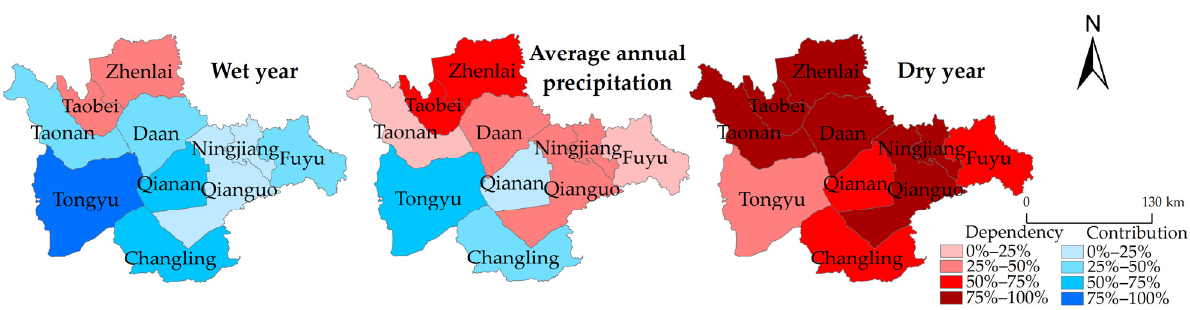
Figure 5. Spatial variation map of the water supply-and-demand balance in western Jilin counties in different precipitation years.